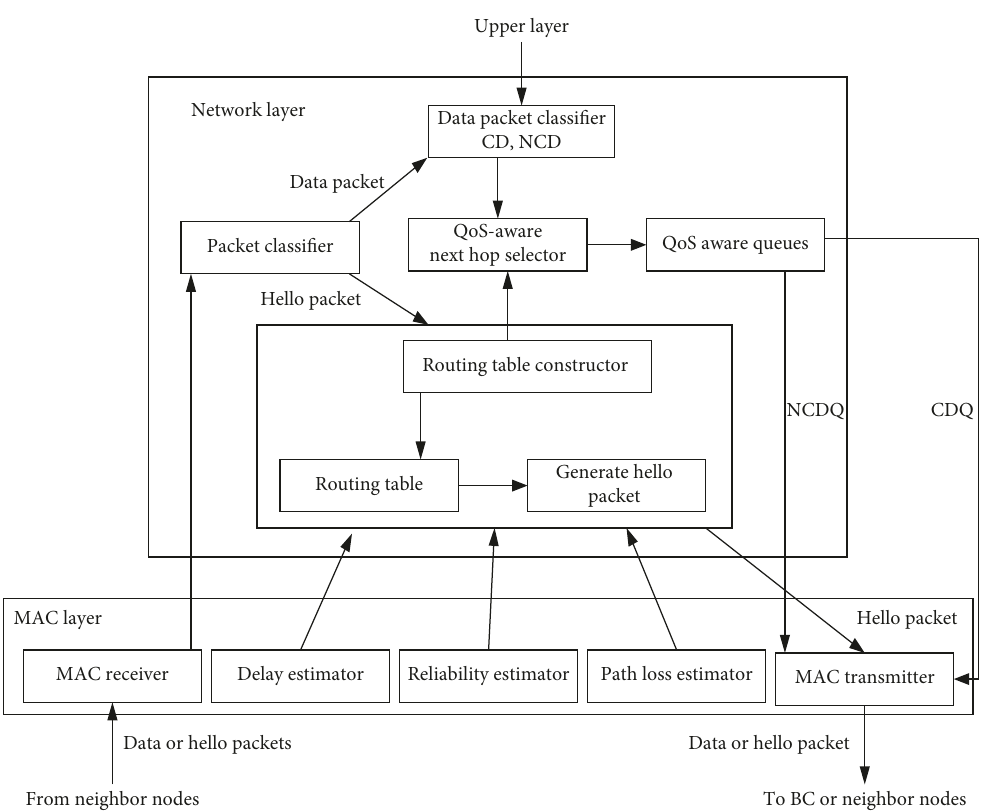
Figure 3: Routing model for efficient routing election in terms of least delay and high